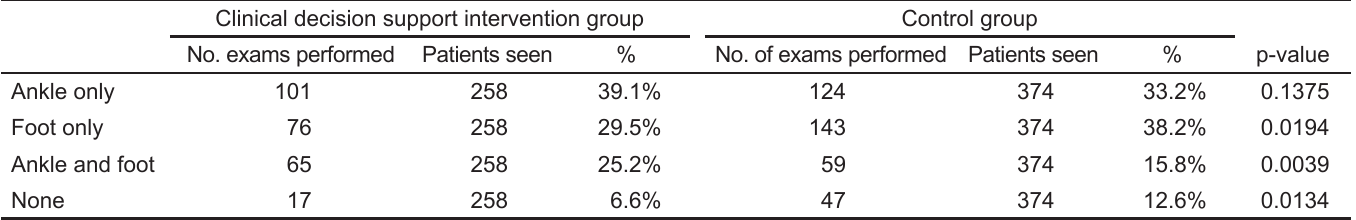
Table 3. Radiography combinations by